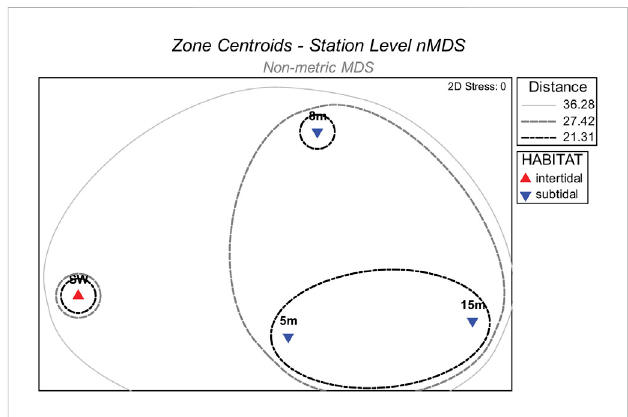
FIGURE 2 Non-metric multidimensional scaling (nMDS) centroids for station groups de fi ned by seaward distance (i.e., swash, 5m, 8m, or 15 m) along with overlayed similarity envelopes delineated by group average cluster analysis